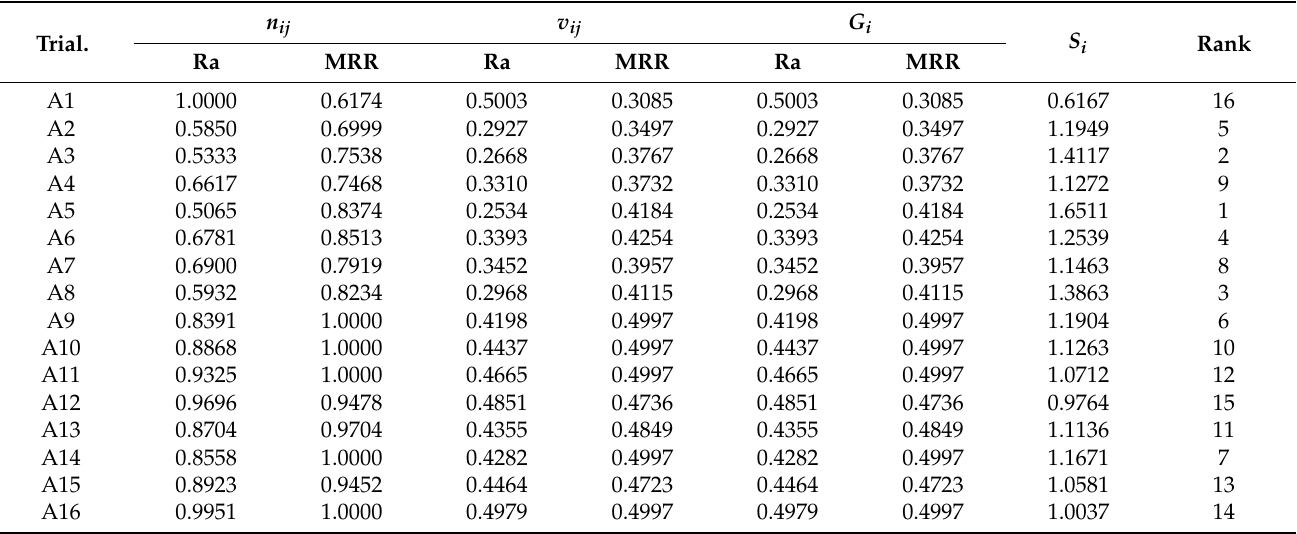
Table 7. Calculated parameters and ranking by the EAMR